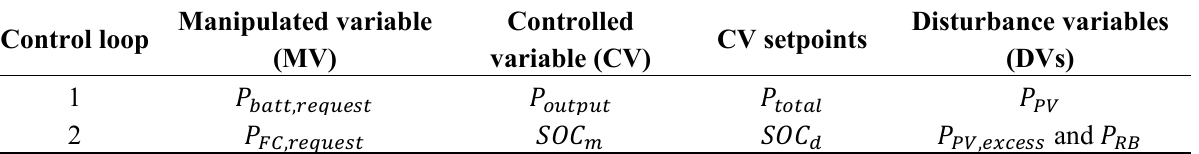
Table 1. PV/fuel cell/battery HRES process variables and control loop